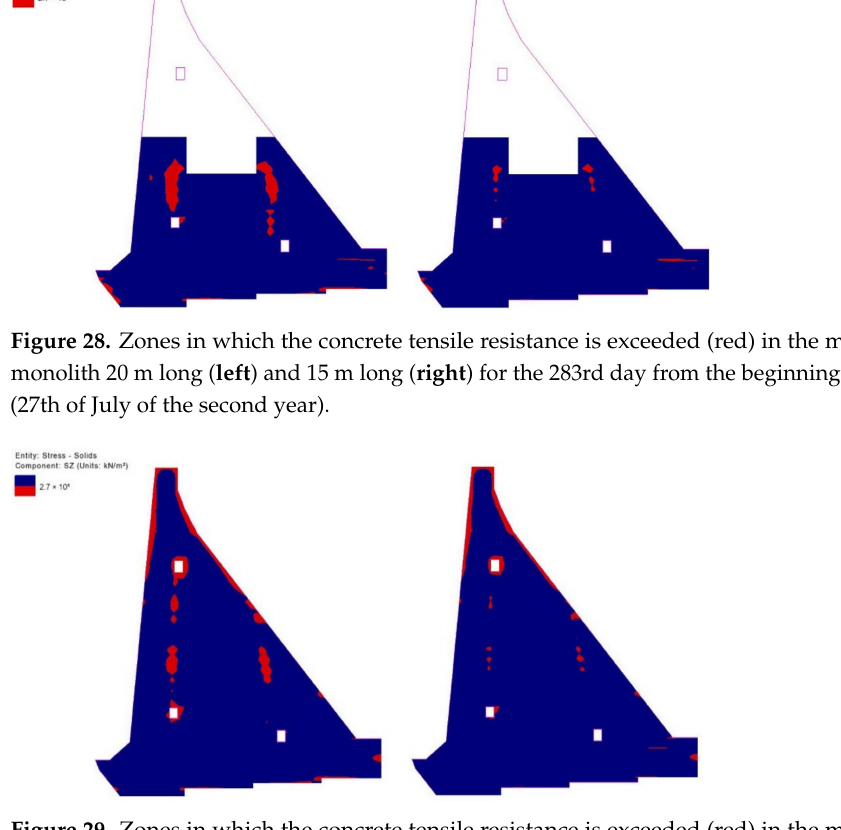
Figure 29. Zones in which the concrete tensile resistance is exceeded (red) in the mid-plane of the monolith 20 m long ( left ) and 15 m long ( right ) for the 512th day from the beginning of construction (13th of March of the third